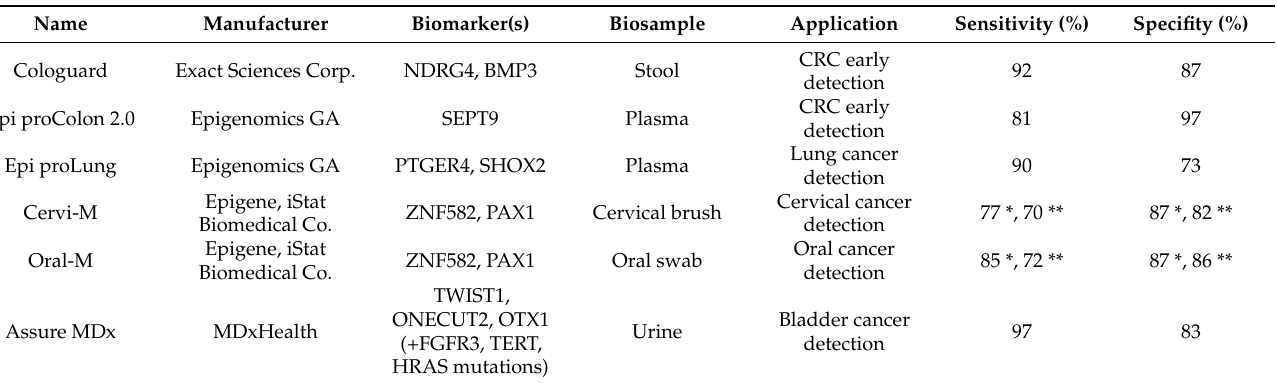
Table 1. Characteristics of clinically approved DNA methylation assays for the detection of different cancers (derived from